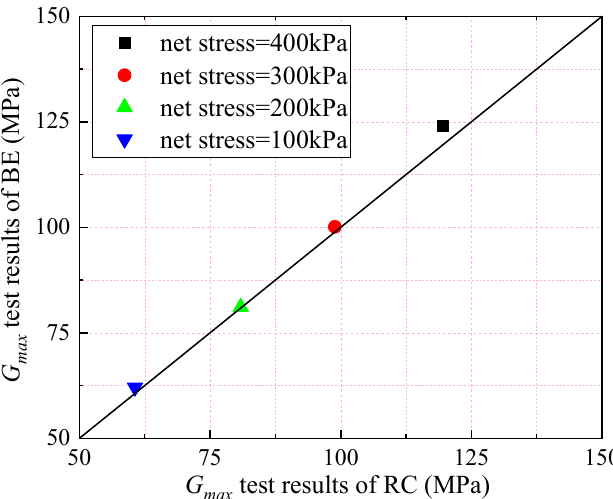
Figure 6. Comparison of G max between the BE and RC test results.